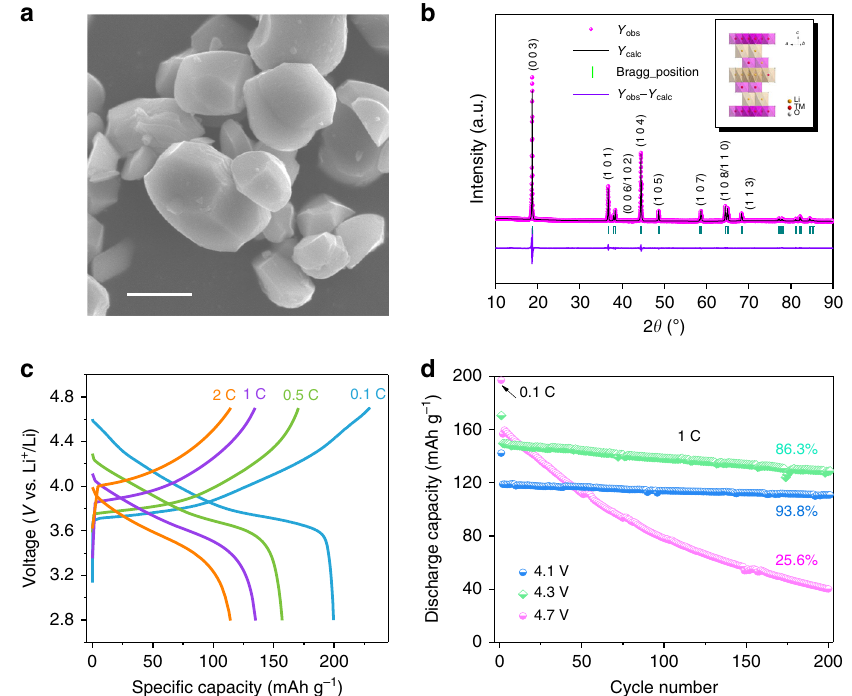
Fig. 1 Performance decay of single-crystal batteries at high-voltage cycling. a SEM images of NCM. Scale bars 2 μ m. b Rietveld re fi nement results for NCM samples (the illustration is the crystal structure of NCM). c Charge – discharge pro fi les of NCM at different rates. d Cycling performances at 1 C (1 C = 270 mA g − 1 ) under different cut-off voltages (4.1, 4.3, 4.7 V).